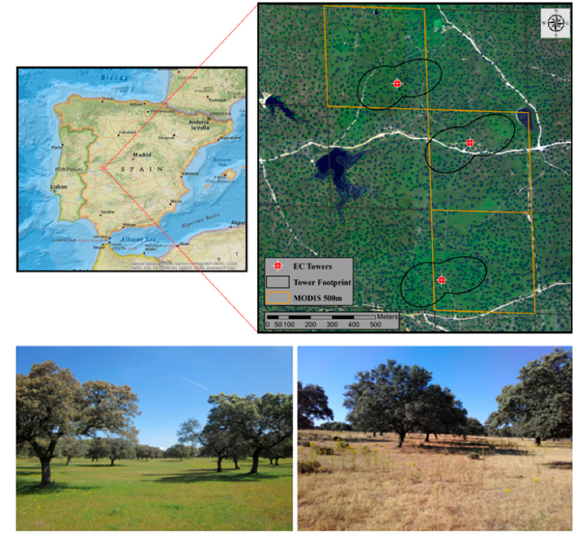
Figure 1. Majadas experimental site (early spring in lower left panel and summer in lower right panel)) and location of the three EC towers (red points), with respective footprints delimited in black (60% iso-lines for the period of March 2014 until January 2017 and estimated according to Kljun et al. [46]). Selected MODIS 500m pixels for LAI estimations (section 2.3.2) are highlighted in orange. The upper left panel reference map was created using ArcMap 10.3 online basemaps (ESRI. ´National Geographic’, http: // www.arcgis.com / home / item.html?id = 30e5fe3149c34df1ba922e6f5bbf808f, 13 December